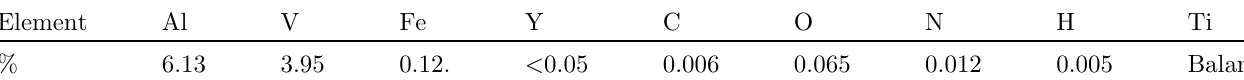
Table 2. Chemical composition of Ti6Al4V powder (in weight percent, wt%).